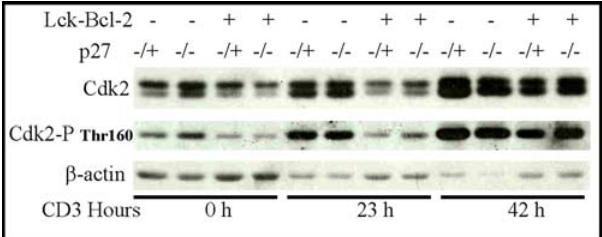
Figure 5. Bcl-2 inhibition of Cdk2 phosphorylation is indepen- dent of p27. T cells from mice of the indicated genotypes were purified and activated with immobilized anti-CD3 antibody prior to harvesting for immunoblot analysis at the time indicated. Immunoblots for total Cdk2, Phospho Thr-160, and Actin as a loading control are